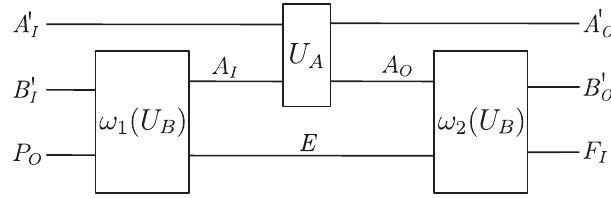
Fig. 7 | Temporal circuit in the bipartite case. Temporal circuit for a bipartite unitary process, with U A being applied on time-local systems A I and A O , and with circuit operations ω 1 ð U B Þ : H B 0 I P O ! H A I E and ω 2 ð U B Þ : H A O E ! H B 0 O F I that depend on U B , and that are connected by an ancillary system E